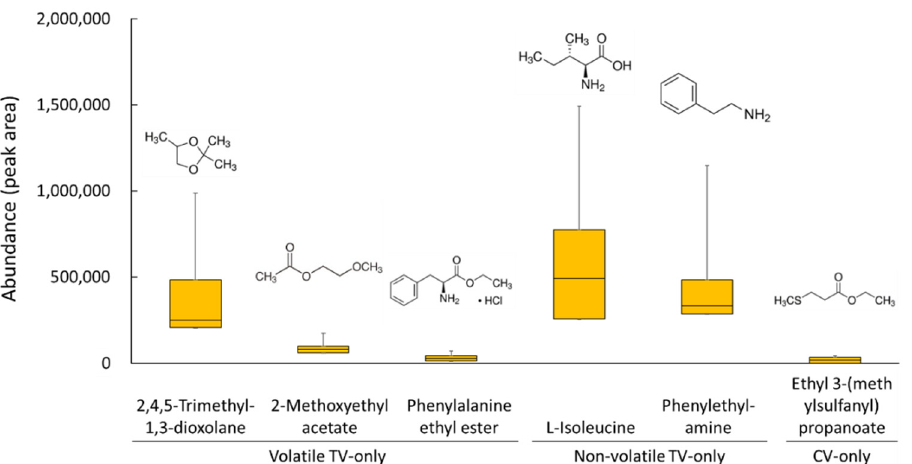
Figure 2. The abundance of six metabolites detected only in traditional vinegar (TV-only) or com- mercial vinegar (CV-only). The interquartile range (boxes), the largest and smallest values (error bars), and the medians (horizontal lines in the boxes) are